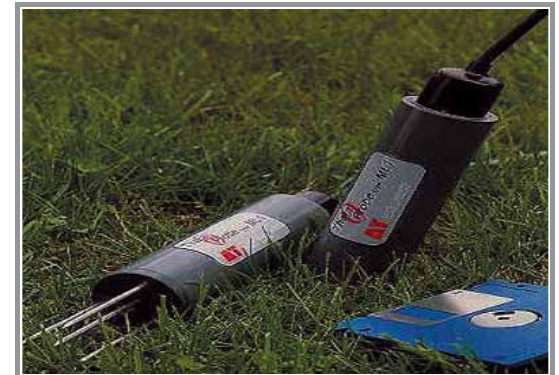
12. TDR Sonda Theta ML2 (Delta – T Devices). UK